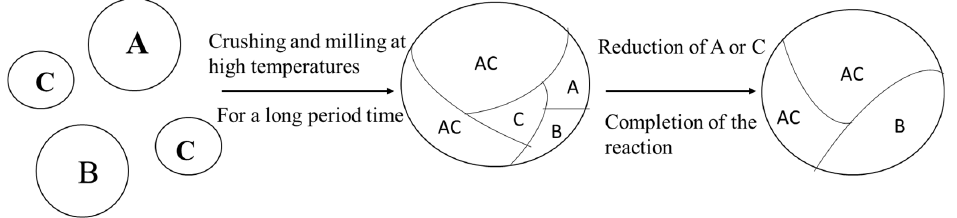
Figure 3. Traditional carbide cermet synthesis processing. Reprinted from Ref. [32] with permission from Mater. Sci. Eng.